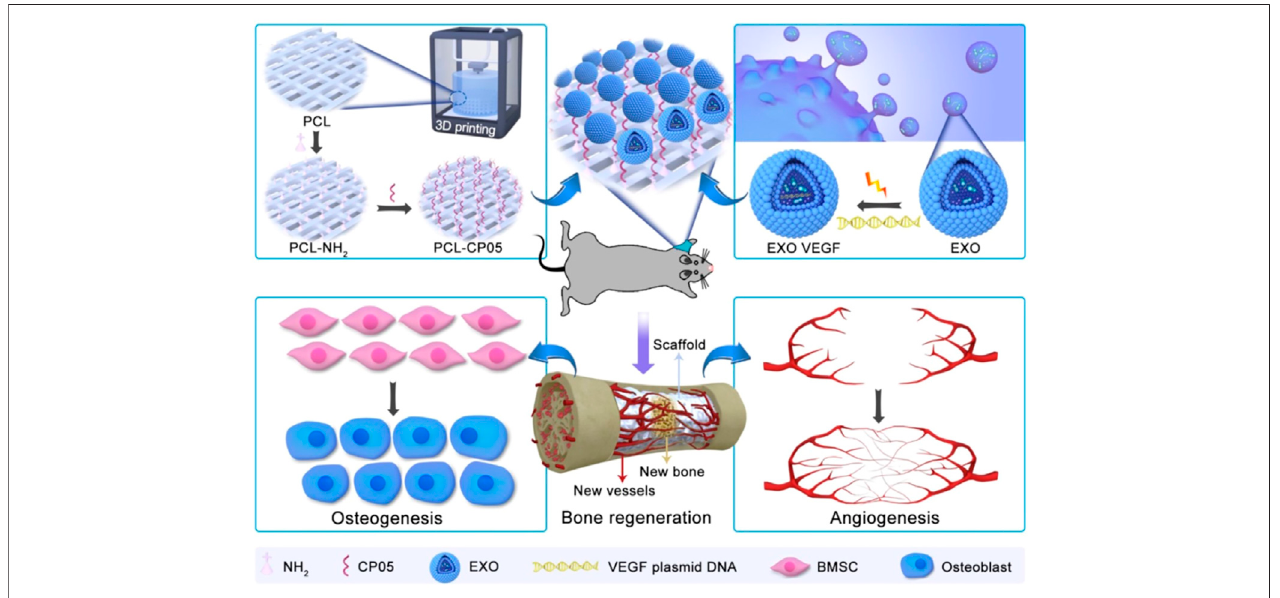
FIGURE 3 | The combination of engineering exosomes endowed with VEGF plasmid with 3D-printed scaffolds promotes bone regeneration via enhancing osteogenesis and angiogenesis (Zha et al.,